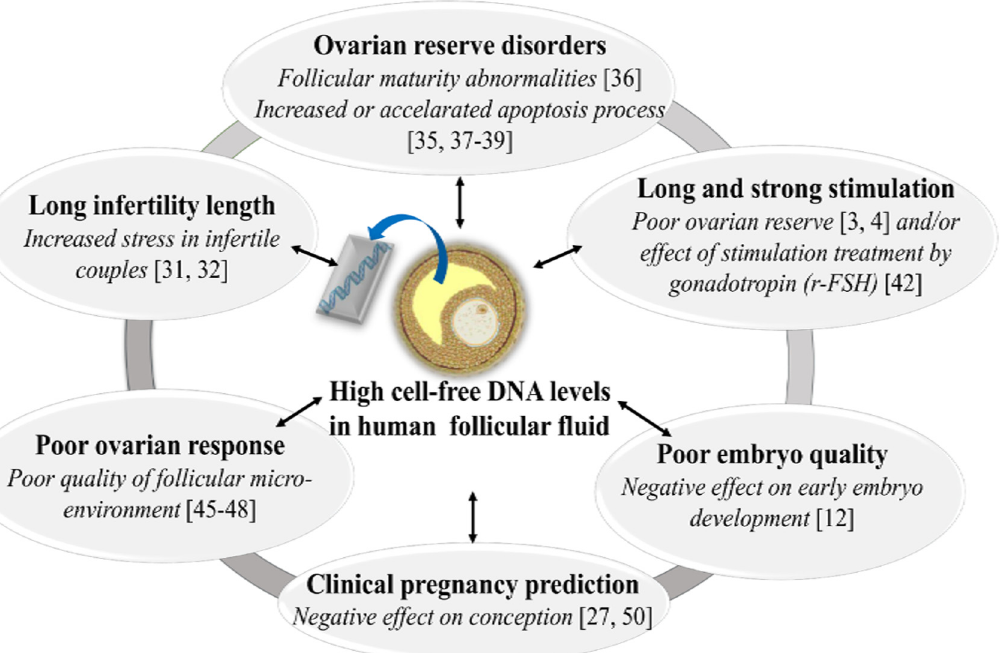
Fig 5. Schematic model summarizing the significant relationships between cell-free DNA levels in human follicular fluid (FF) and: infertility length, ovarian reserve status, ovarian stimulation, ovarian response to stimulation, embryo development and clinical pregnancy outcomes, respectively. High cell-free DNA levels in human FF reflect a poor quality of follicular micro-environment and consequently are related to a poor IVF prognosis. r-FSH, recombinant FSH.